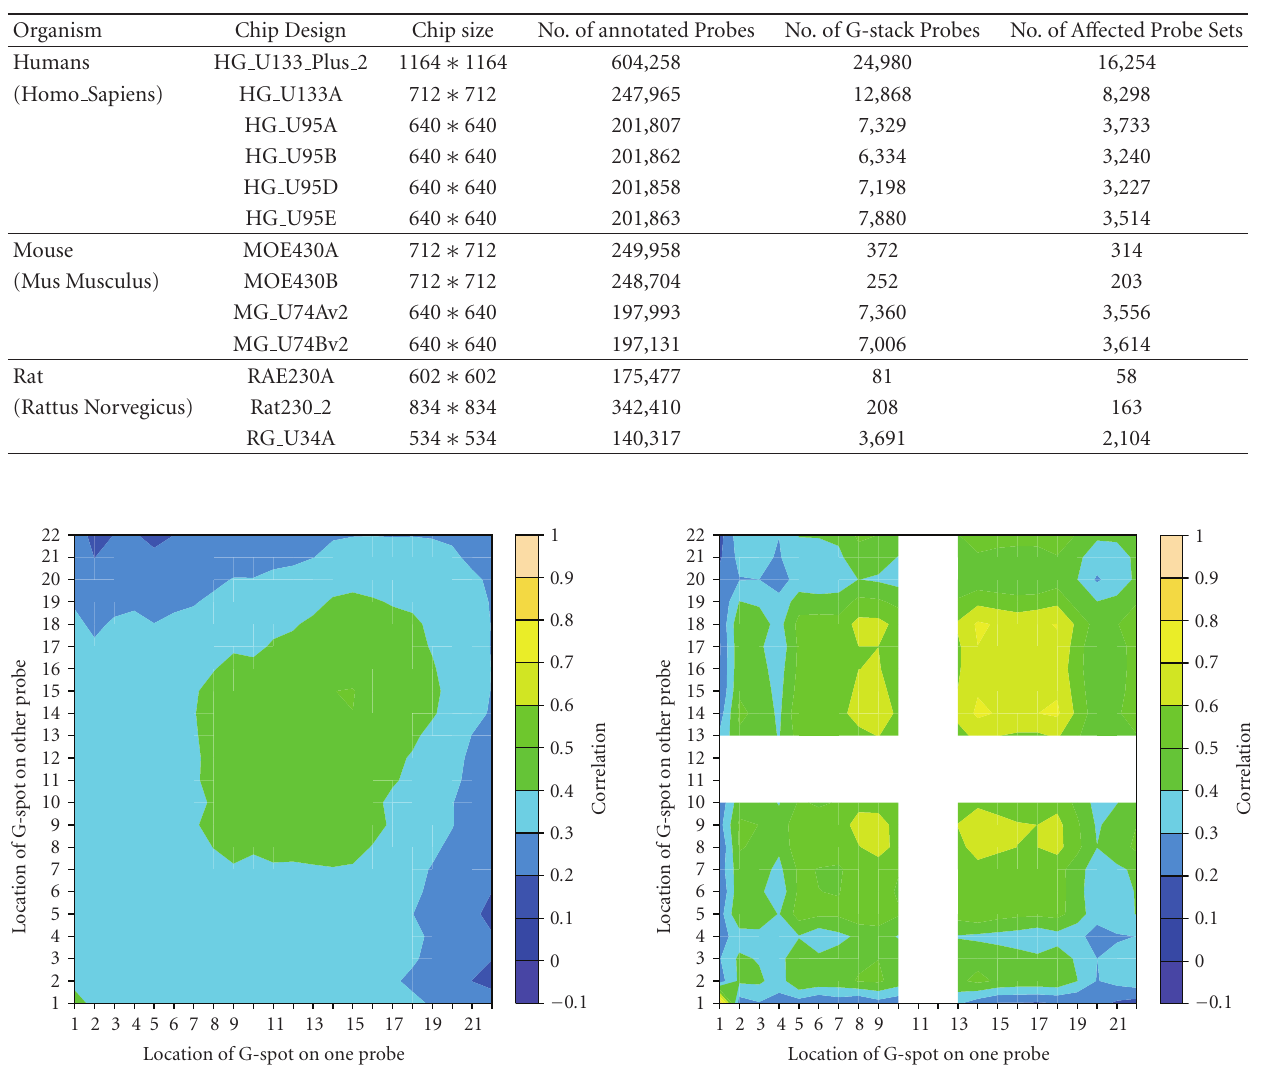
Table 1: List of organisms and their chip designs used in this study. The number of annotated probes and the number of G-stack probes include both the main and control probes.